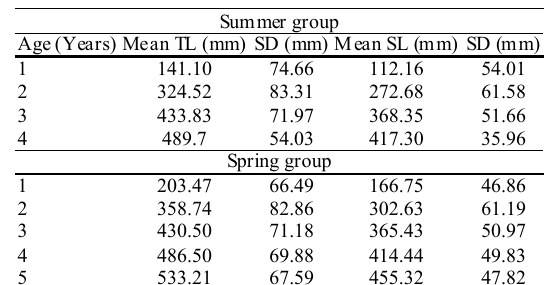
Table 1. Back-calculated mean total length (TL) and standard length (SL) at time of scale-ring formation and the respective standard deviations (SD) for each trahira group.